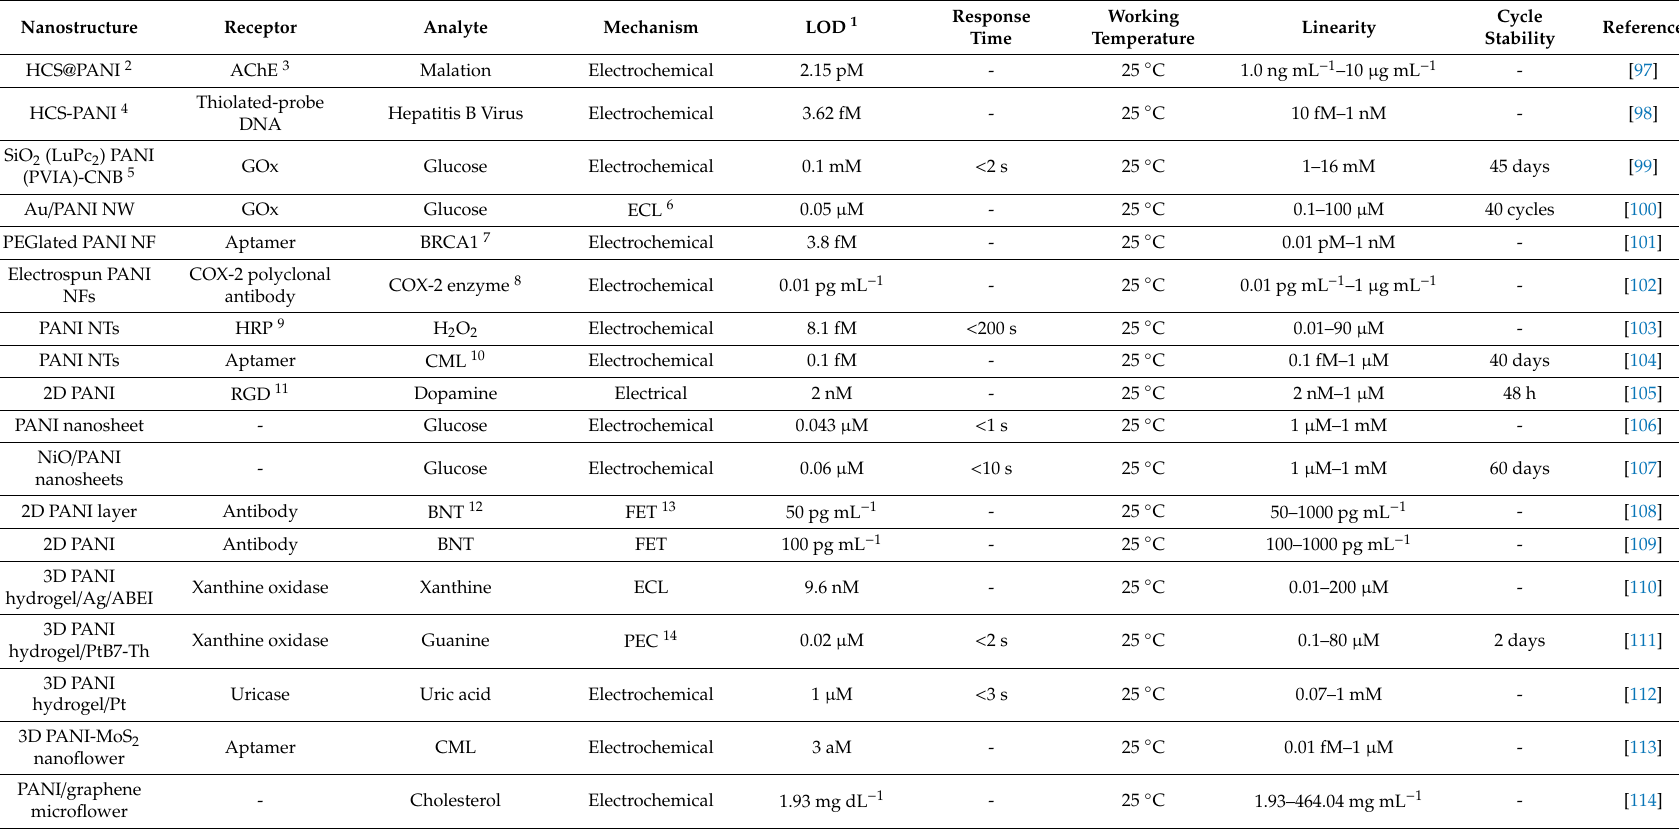
Table 2. Comparative sensing performance and limit of detection of polyaniline nanostructure-based